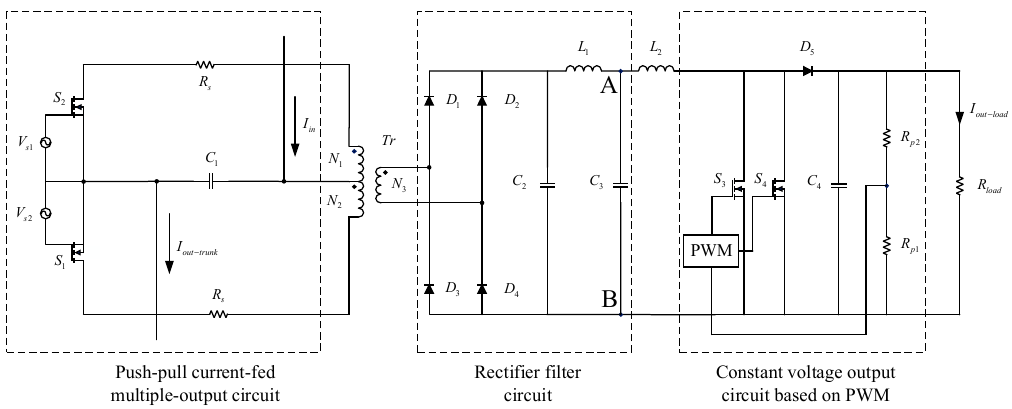
Figure 4. Schematic diagram of isolated output-voltage adjustable constant-current to constant-voltage (CC–CV) converter circuit based on pulse width modulation (PWM) feedback.